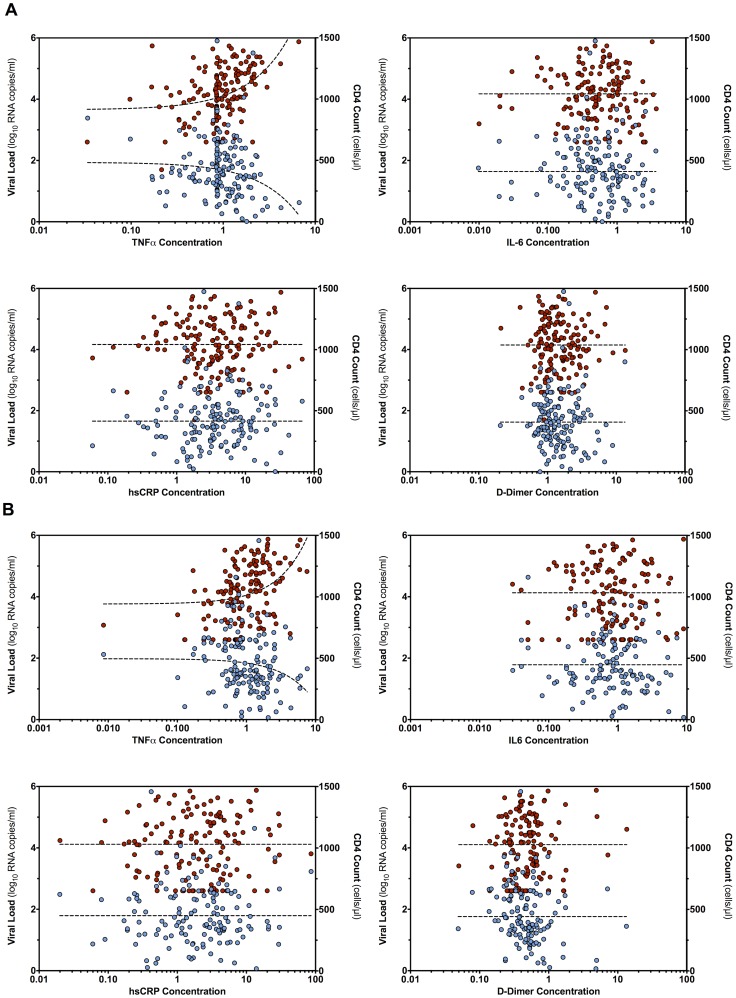
Association of viral load and CD4 count with cytokine expression.Viral load (red) is shown on the left y axis, and CD4 count (blue) on the right y axis. (a) association with cytokine expression at enrollment; (b) association with cytokine expression at six months postpartum.